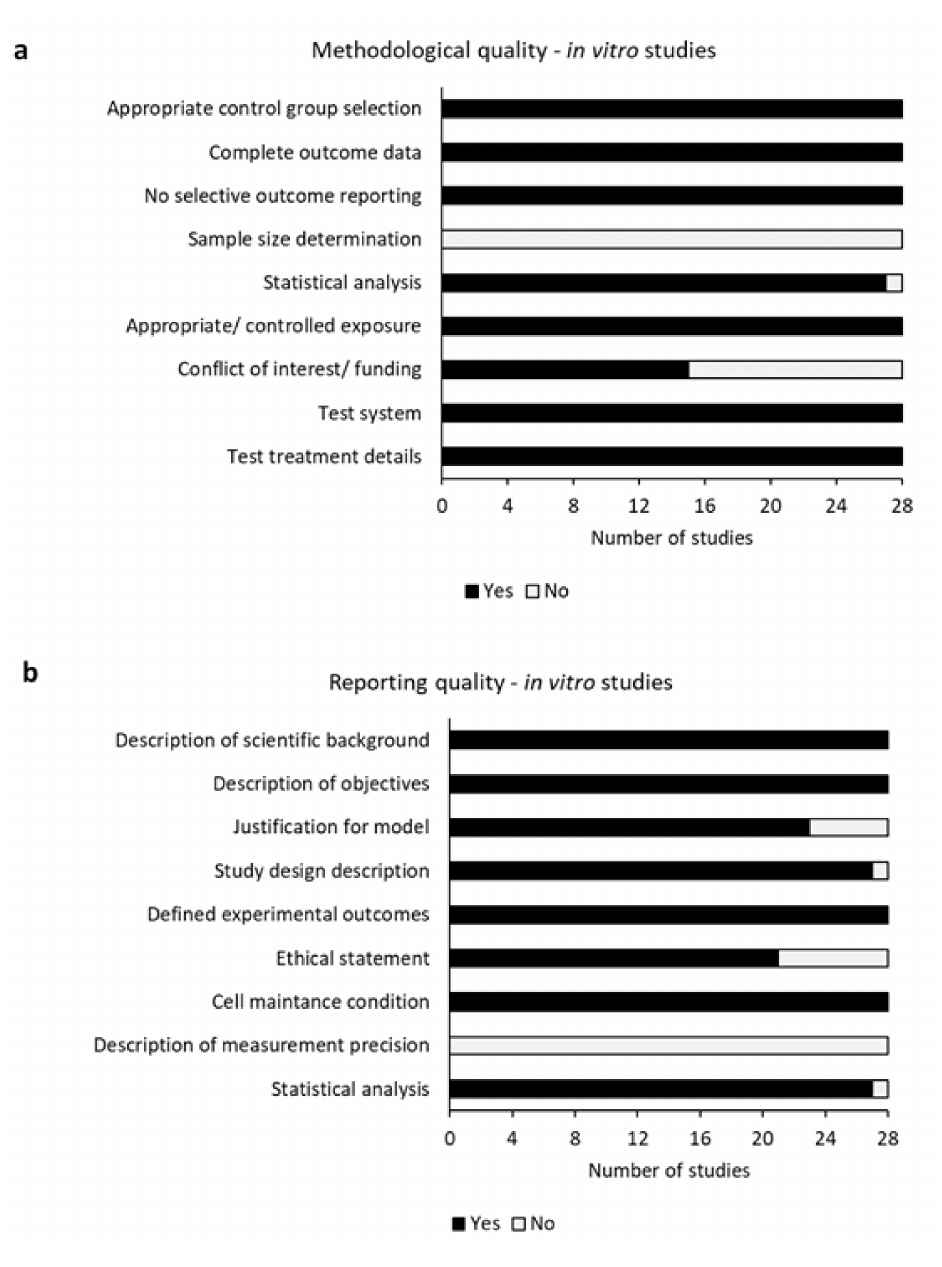
Figure 2. Risk of bias assessment of all included in vitro studies. Risk of bias was evaluated by assessing various methodological ( a ) and reporting ( b ) criteria, which was adapted from Samuel et al.,